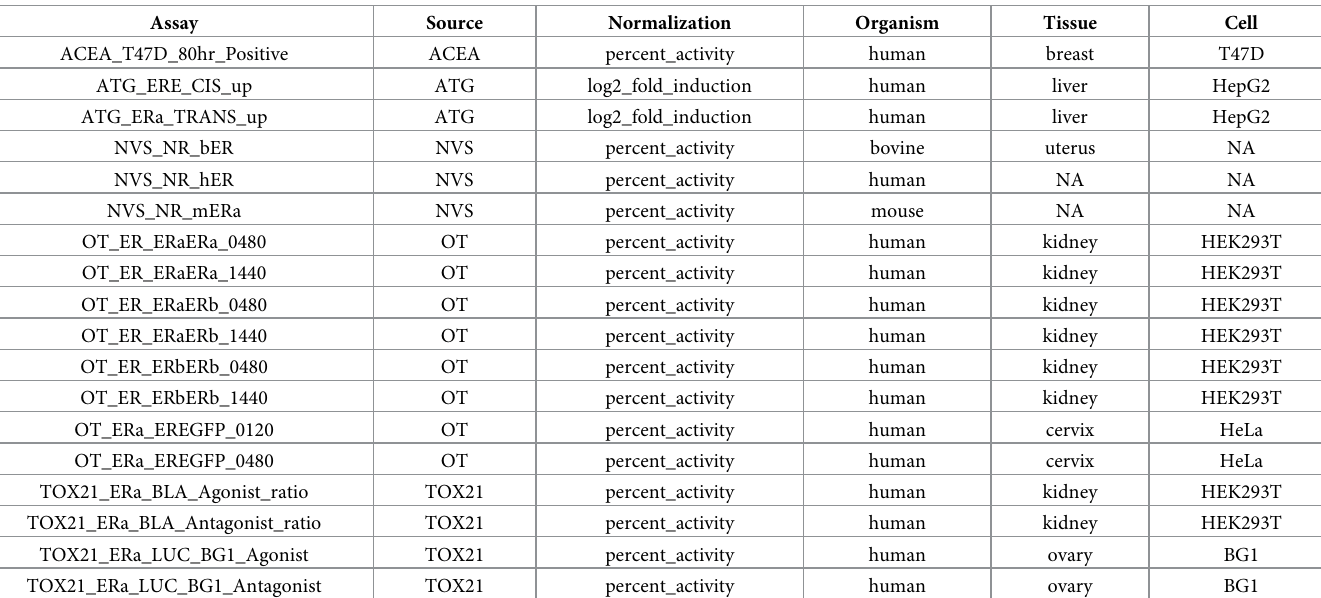
Table 2. Estrogen receptor assays included in this study. Assay Source Normalization Organism Tissue